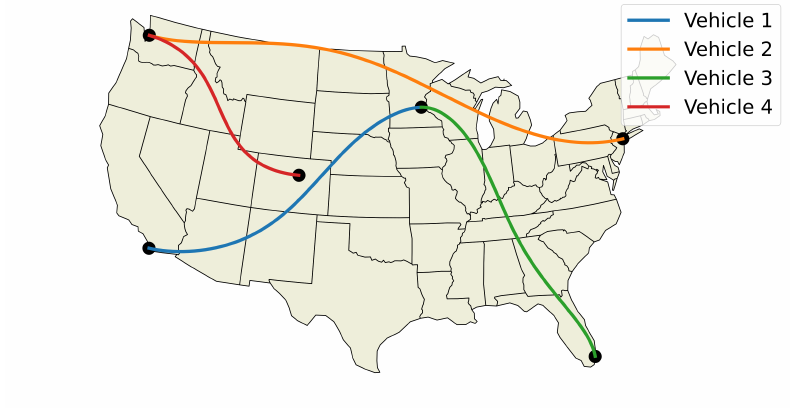
Figure 26. Commercial flight trajectories between major US